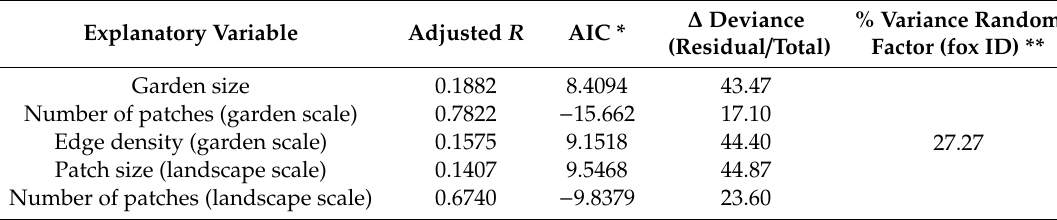
Table 3. Model fits for significant bivariate linear mixed models (lmm) explaining core area size in urban foxes. These were also run as generalized linear mixed models (glmm) to generate ∆ deviance (change in deviance attributed to the explanatory variable as a percentage of total deviance (residual + null)). * Akaike Information Criterion; ** percentage of the total variance explained by the random factor fox ID (i.e., residual variance / total